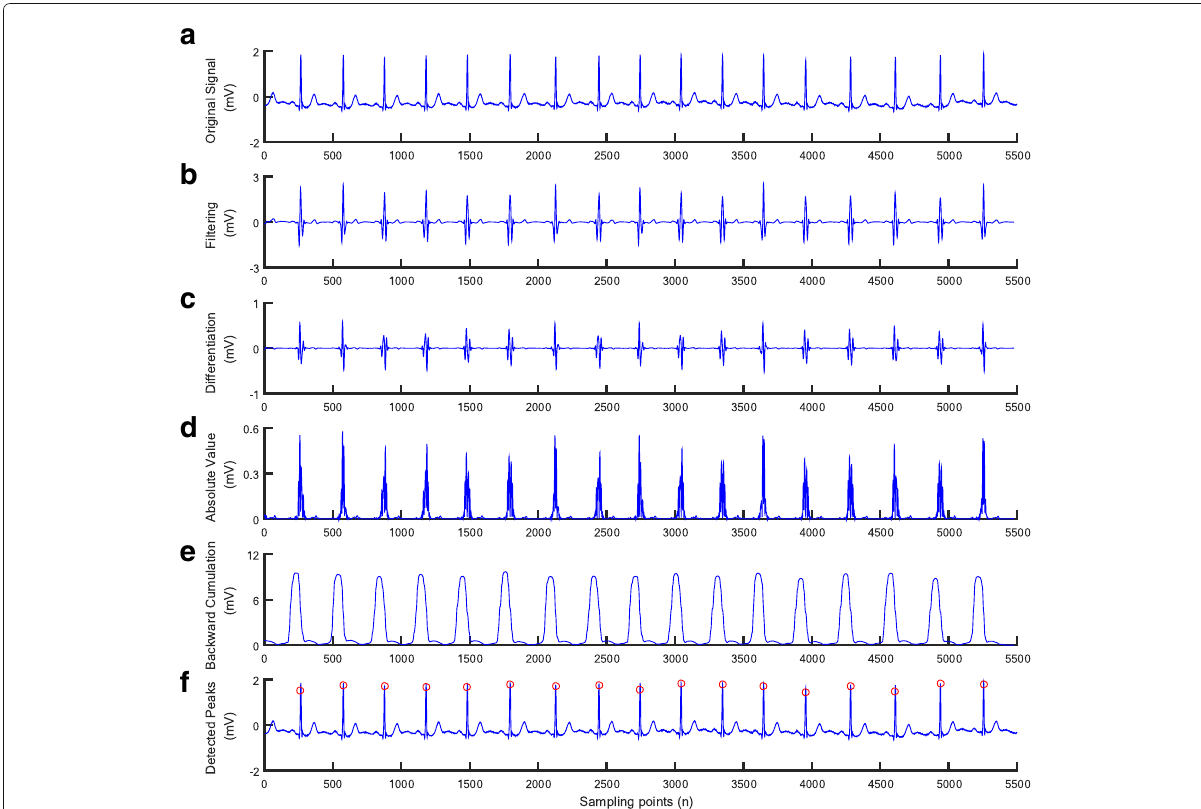
Fig. 10 Result after performing each stage of the method for the ECG with sudden changes of QRS complex waveforms and serious baseline wander (ECG recording 103). a ) Original signal. b ) Filtering. c ) Differentiation. d ) Absolute value. e ) Backward cumulation. f ) Detected peaks